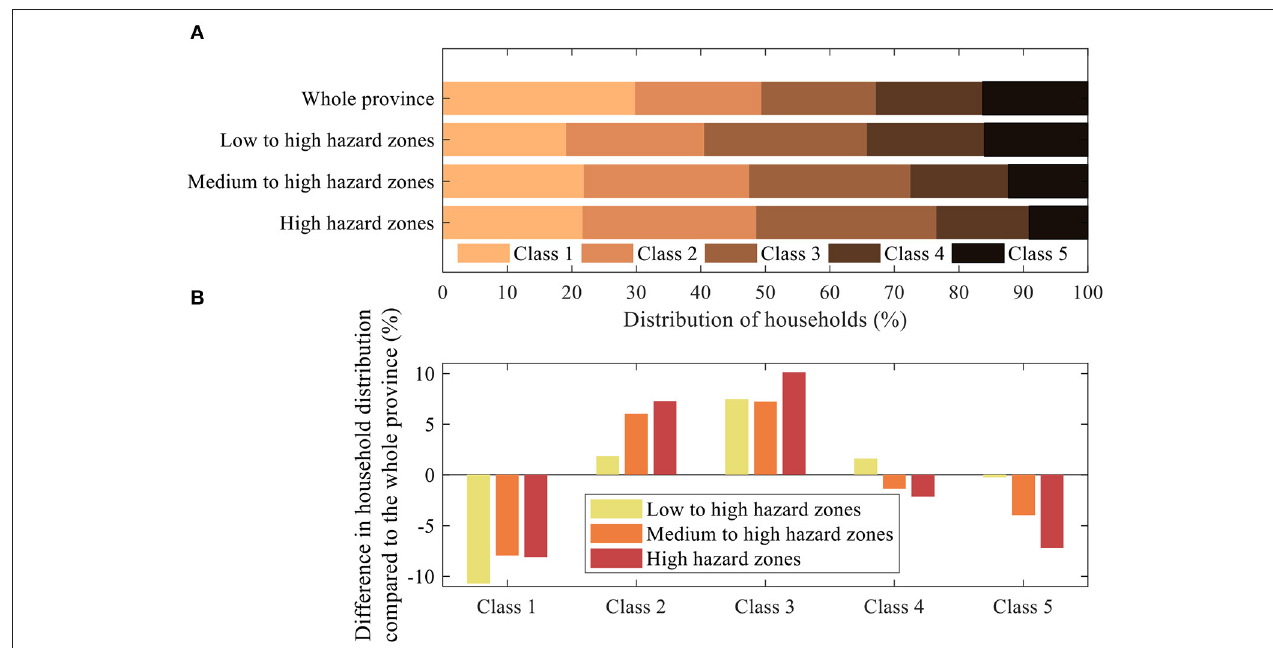
FIGURE 6 | (A) Distribution of households as a function of their ISD class, in the whole province and in flood-prone areas defined by to different ranges of hazard (low to high, medium to high, or high only); and (B) difference with respect to the household distribution in the whole province.